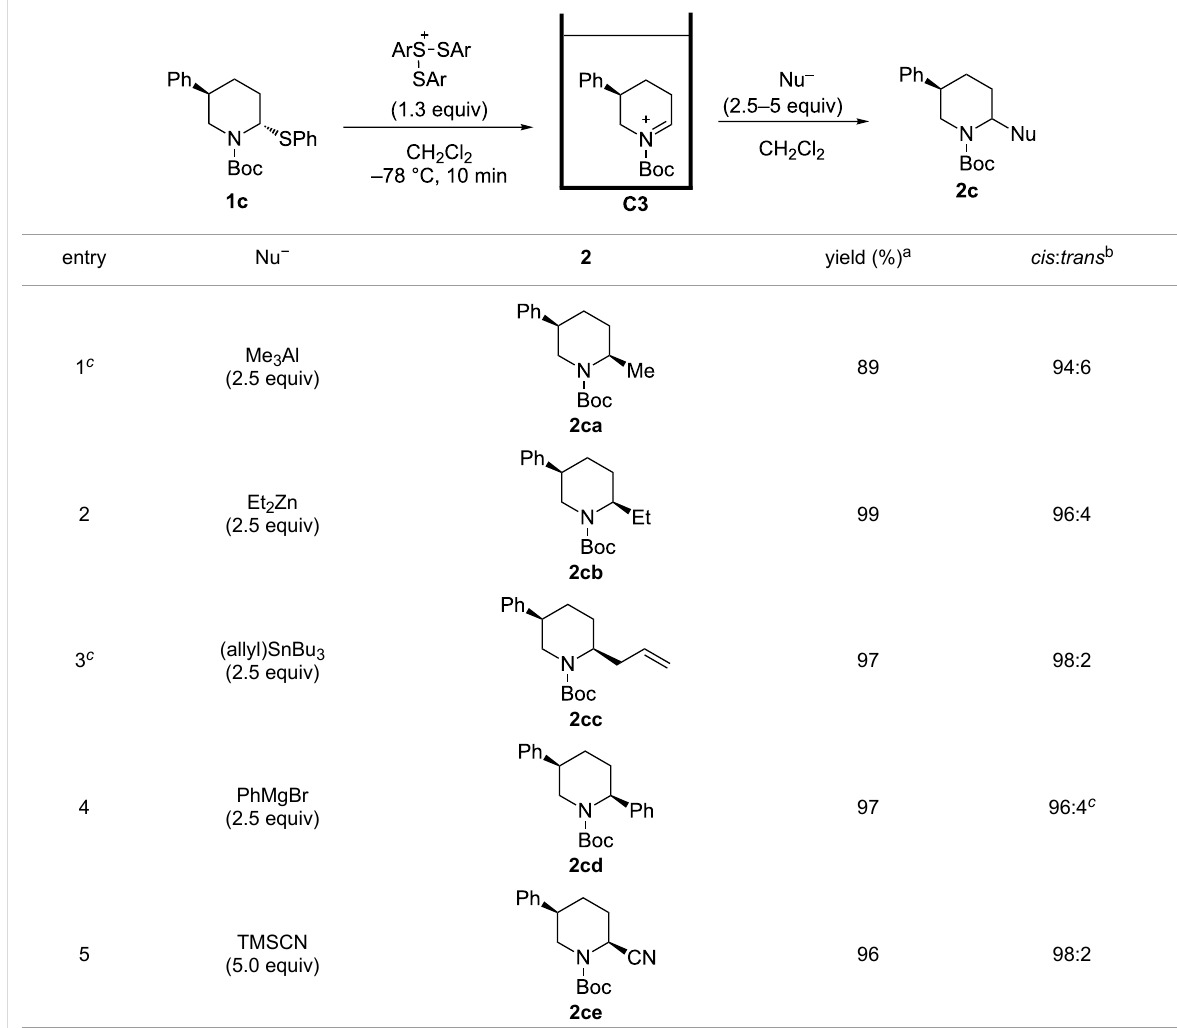
Table 3: Reaction of N- acyliminium ion C3 with several